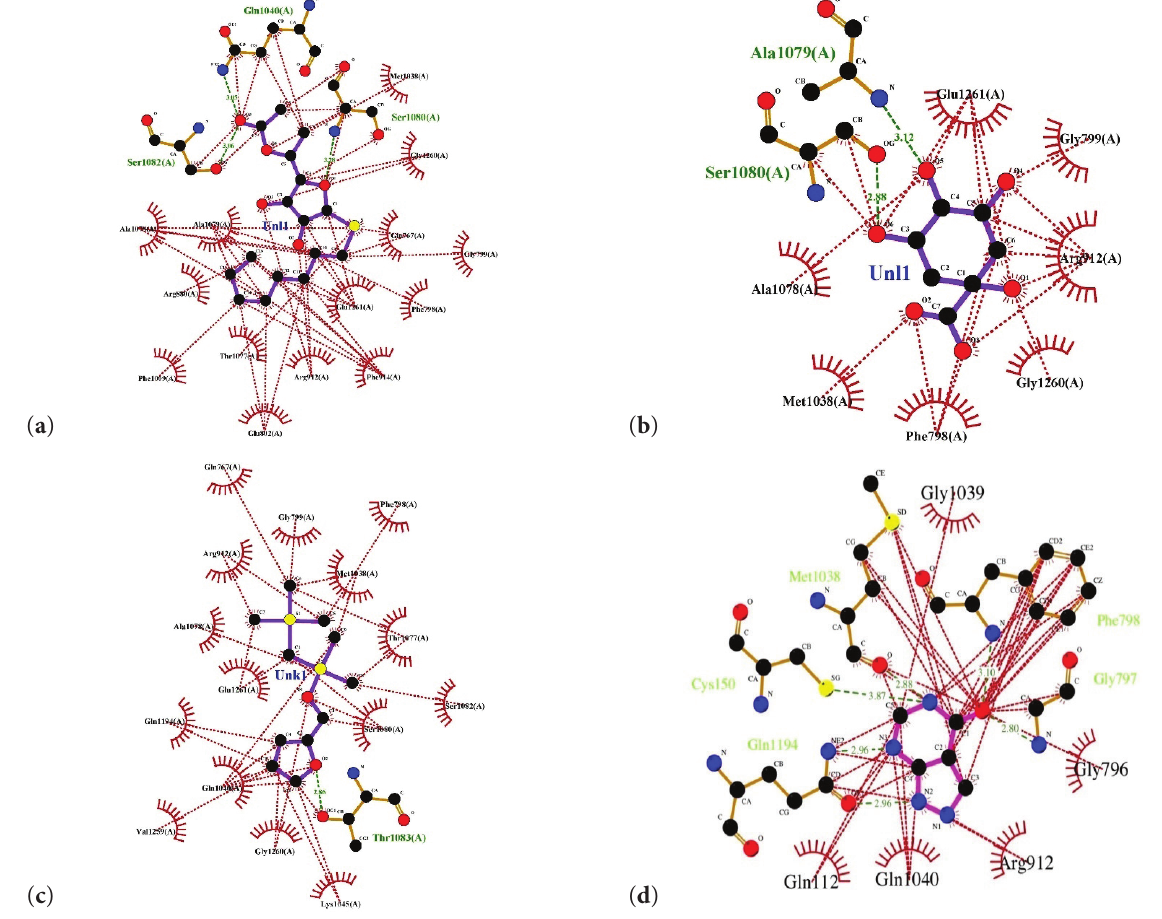
Figure 8. Hydrophobic interaction of ligand in complex with the receptor. ( a ) 5-O-acetyl-thio-octyl-β-L-rhamnofuranoside, ( b ) Quinic acid, ( c ) 2-Dimethyl(trimethylsilylmethyl)silyloxymethyltetrahydrofuran, ( d ) Allopurinol (control). The ligand refers to the stick model in magenta color. Redline is represented hydrophobic interaction between ligand and residues of the